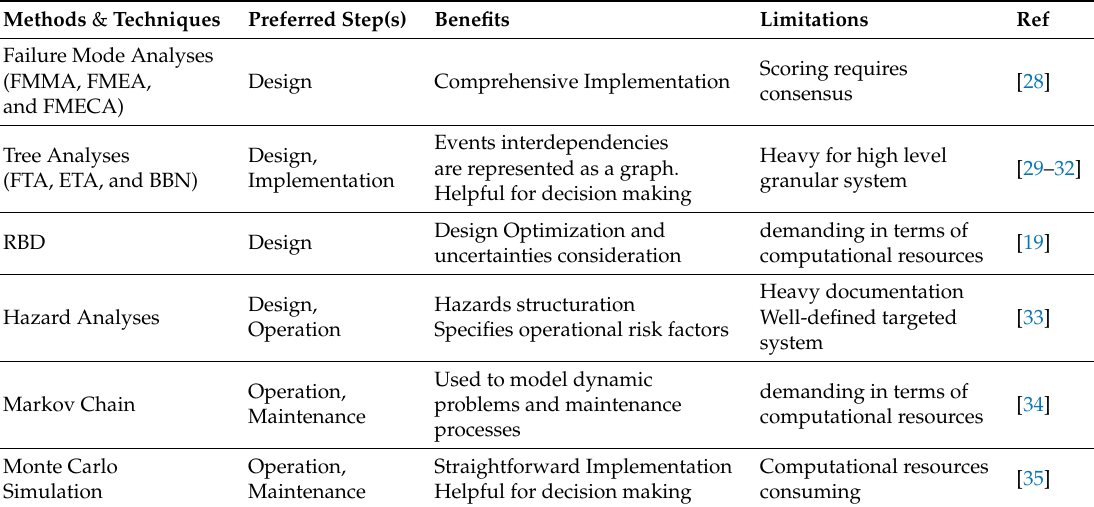
Table 1. Comparison of some reliability assessment